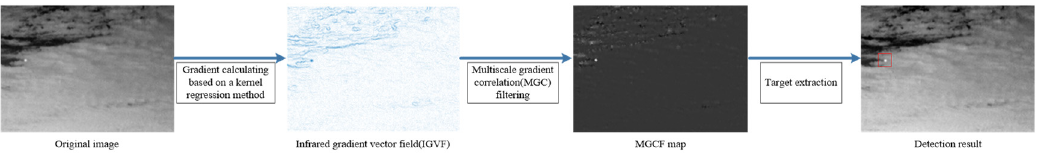
Figure 4. Detection framework of the proposed MGCF method.